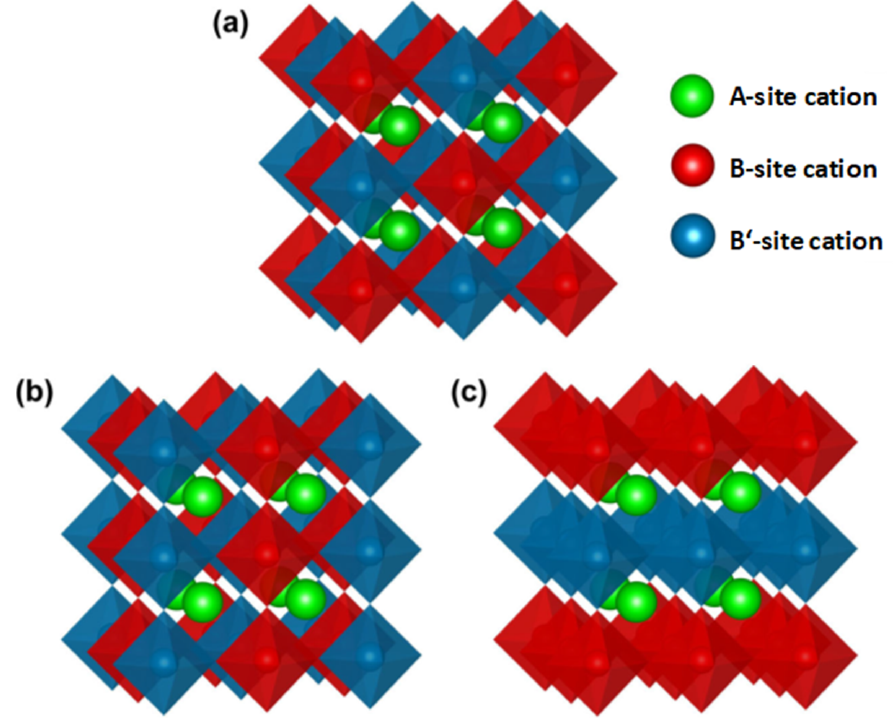
Figure 1. Three different types of the B-site ordering: ( a ) NaCl type; ( b ) columnar; and ( c ) layered, redrawn with the program Vesta (ref. [18]).